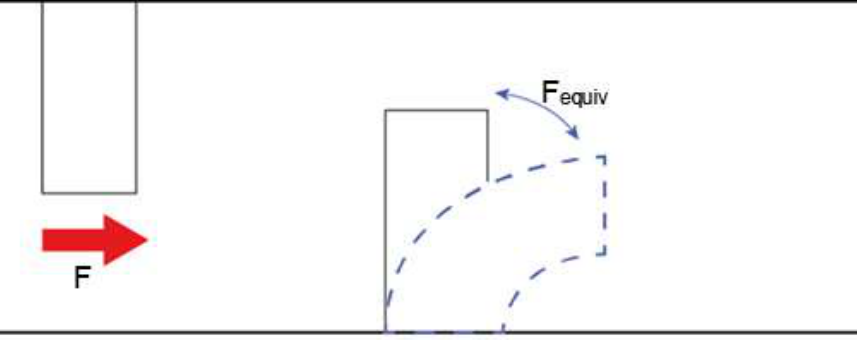
Figure 4. F is the impact force caused by the top asperity. F equiv is the force generated by the vibration of the bottom asperity due to the previous impact.